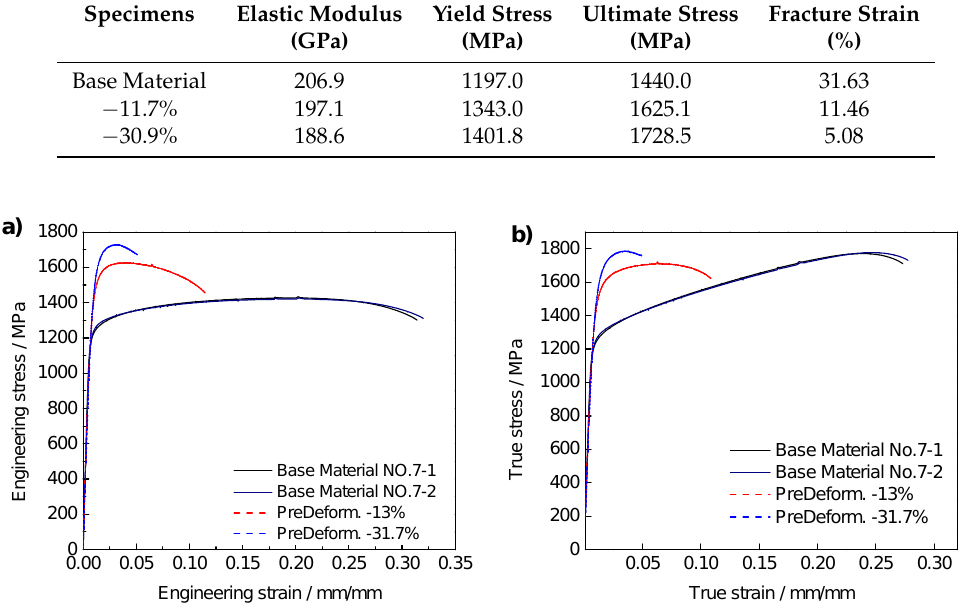
Figure 3. Results of the Stress–Strain relationship of the base material and pre-deformed IN718. ( a ) Engineering stress–strain curves. ( b ) True stress–strain